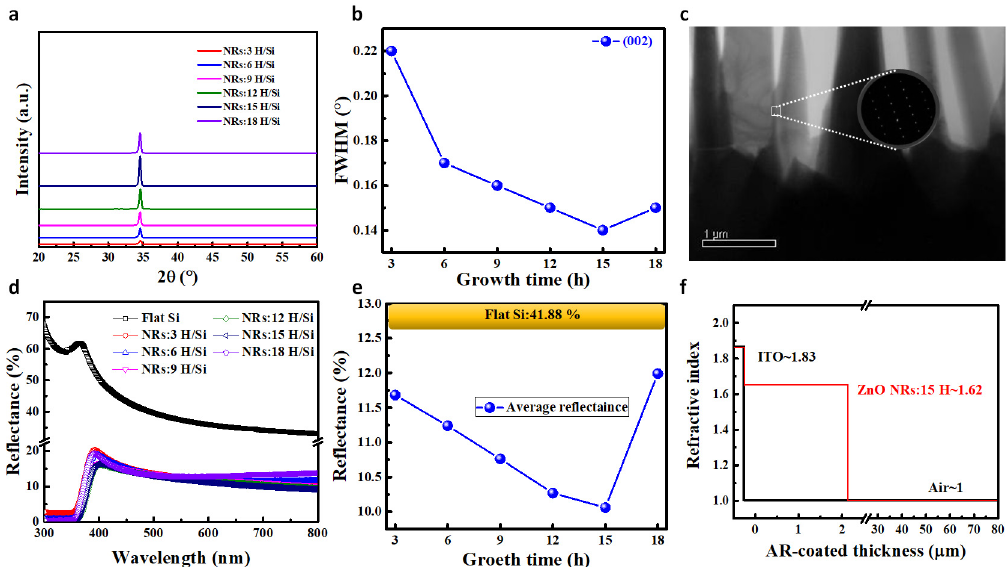
Figure 3. ( a ) XRD measurements. ( b ) The FWHM values of ZnO (002) planes. ( c ) TEM images and SAED patterns of ZnO NRs with 15 h of growth. ( d ) Reflectance results. ( e ) Average reflectance results. ( f ) Schematic plot of changes in the refractive index of a-Si:H thin-film bare photovoltaic cells and a-Si:H thin-film photovoltaic cells with ZnO NRs on the surfaces.